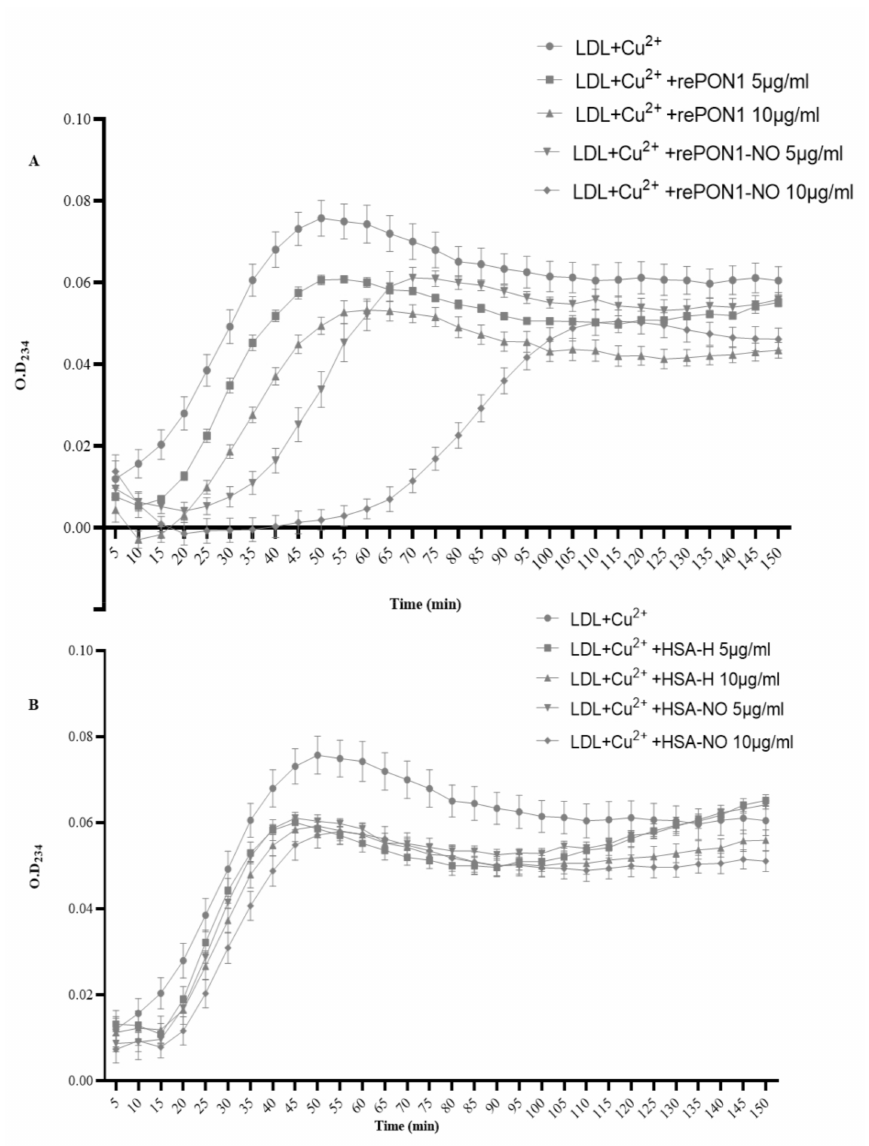
3.3. Effect of S-Nitrosylation on rePON1 Antioxidant Activity: Protection of LDL from Oxidation The ability of rePON1-NO to protect LDL from oxidation induced by Cu 2+ was examined. RePON1 and rePON1-NO (55% S-nitrosylated as detected by Q-TOF LC/MS) were incubated with LDL and Cu 2+ . Oxidation of LDL fatty acids produced conjugated dienes, and their absorbance at 234 nm was monitored every 5 min for 2.5 h. RePON1 delayed LDL oxidation rate in a dose- and time-dependent manner (Figure 3A). RePON1- NO showed better prevention of LDL oxidation than rePON1 (Figure 3A).